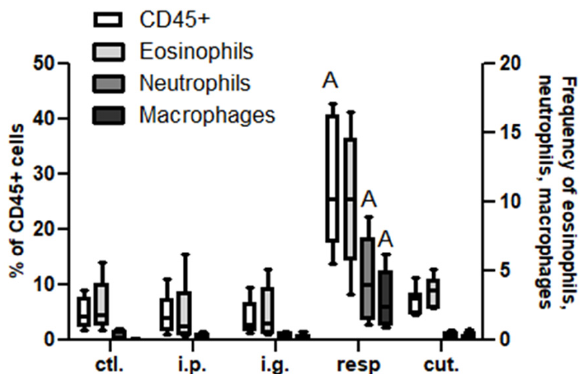
Figure 6. Inflammatory cells in BAL : Frequencies of CD45+ (empty bars), eosinophils (light gray bars), neutrophils (dark gray bars), and macrophages (black bars) in BAL from different groups of exposed mice. Inflammatory cells were defined within CD45 + CD3 ₋ cells as neutrophils (Ly6C + Ly6G + ), eosinophils (SiglecF + CCR3 + within LyG6 ₋ ), and macrophages (Ly6C ₋ F4/80 + within LyG6 ₋ ). All frequencies are expressed using CD45 + cells as a reference. “A” indicates a significant difference between indicated group and control group ( p < 0.05 using non-parametric Kruskal–Wallis and Dunn’s post-Test).